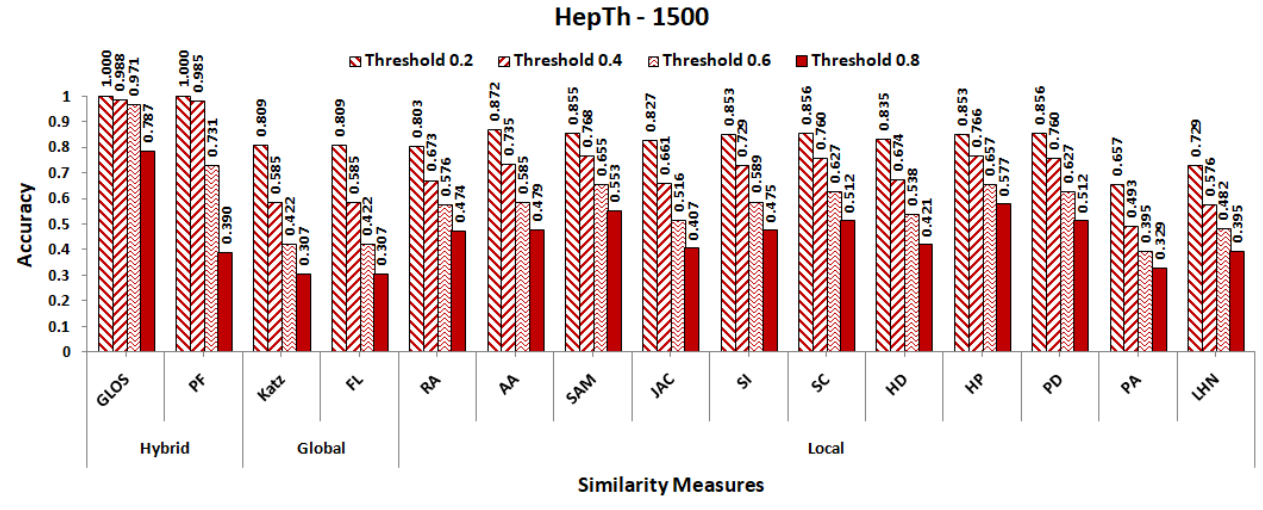
Figure 20. Comparisons of similarity measures on HepTh-1500 edge list from HepTh